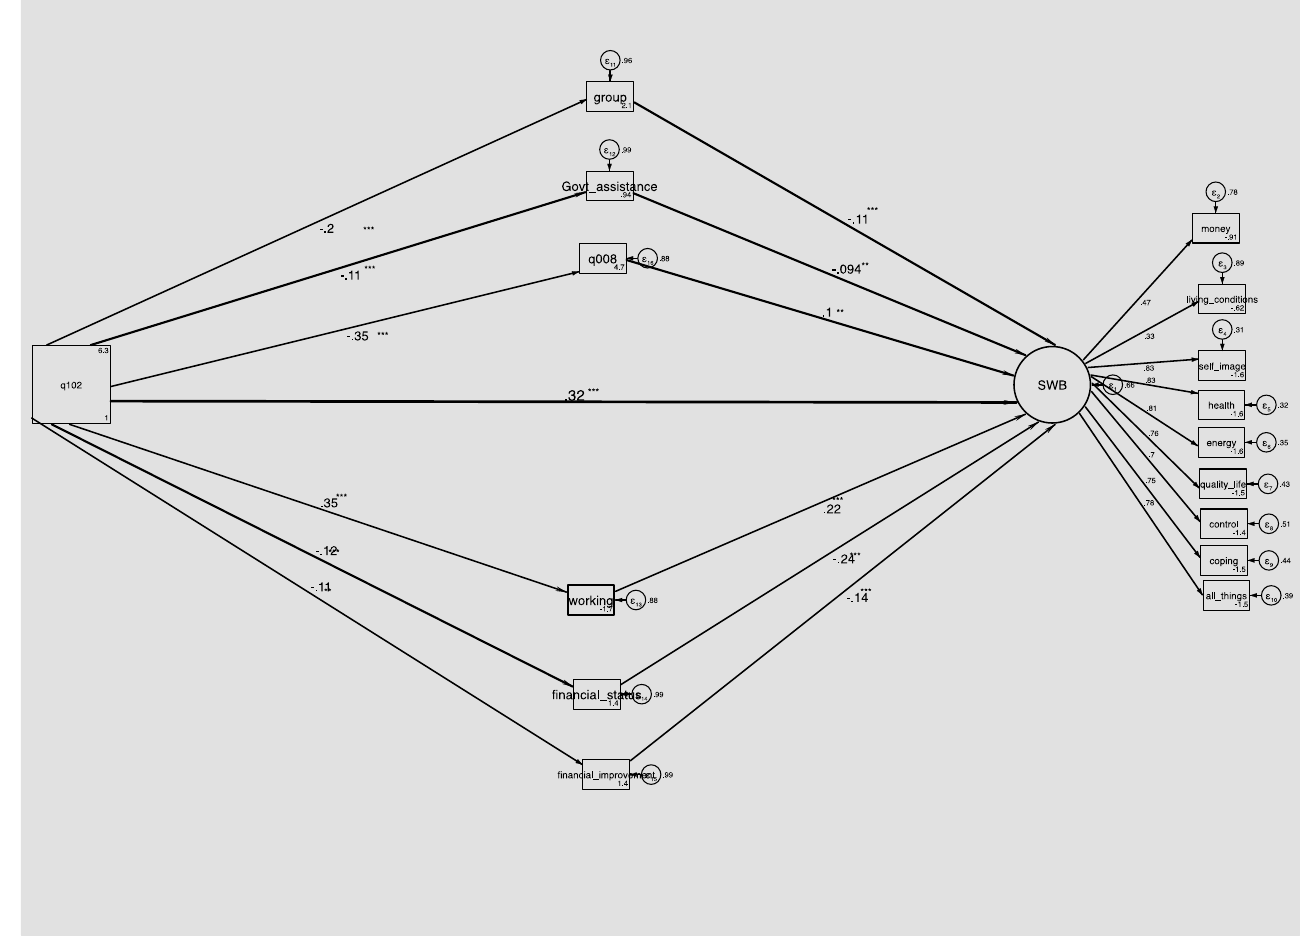
Figure 2. Indirect pathways between aging and subjective wellbeing in Central Uganda. SWB = subjective wellbeing in decreasing order, q101 = age, q008 = district of residence, q112 = religion, q101 = gender. ** p < 0.01, *** p < 0.001